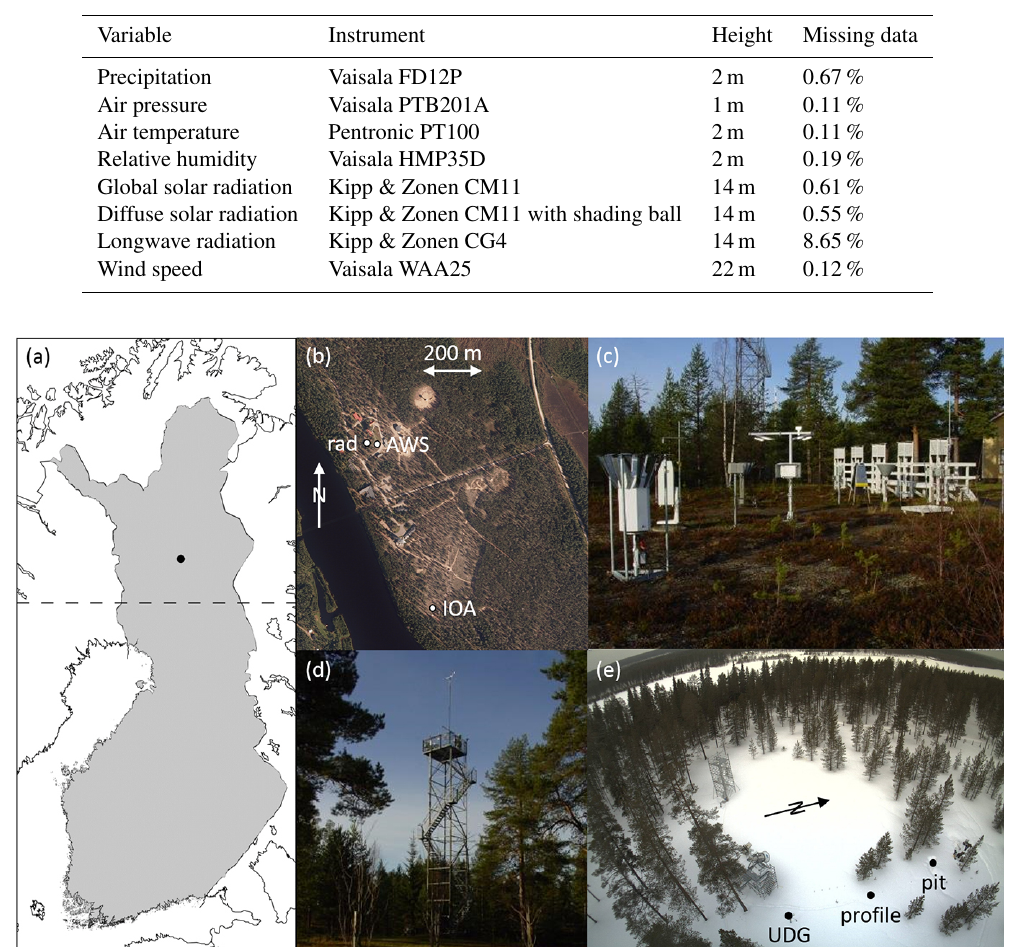
Figure 1. (a) The location of FMI-ARC (dot), 90km north of the Arctic Cirle (dashed line) in Finland. (b) Orthophotograph of the FMI- ARC site, showing the locations of the automatic weather station (AWS), the radiometer tower (rad) and the intensive observation area (IOA). (c) The automatic weather station, with the radiometer tower in the background. (d) The radiometer tower. (e) The IOA, showing the locations of the ultrasonic depth gauge (UDG), the snow temperature profile and the snow pit for manual